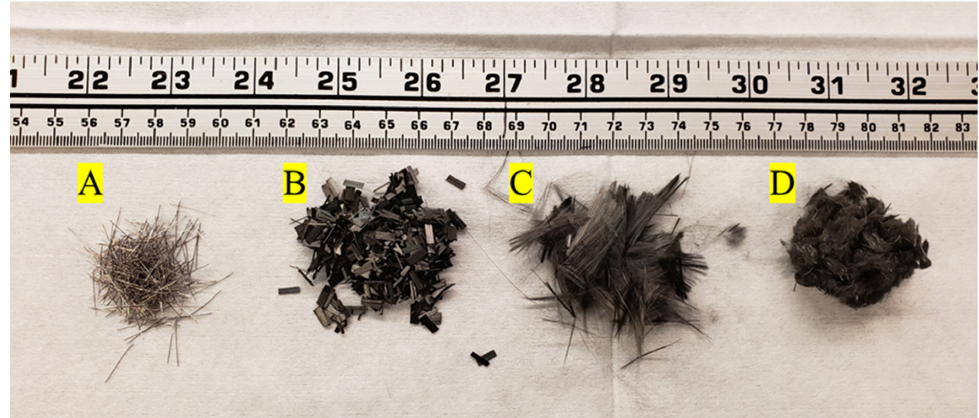
Figure 1. Different fiber types mixed into concrete. ( A ) steel fibers; ( B ) Hexcel carbon fiber platelets; ( C ) Zoltek carbon fiber; ( D ) recycled carbon fiber.